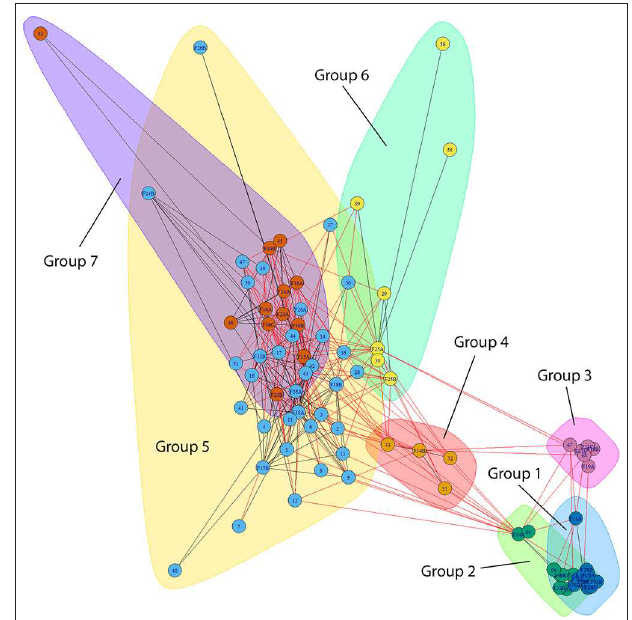
FIGURE 5 | Bipartite graph of network analysis from Tosenfjord tracking data including marine receivers (two-digit numbers) that were operative from 2015 to 2017 tagged fish (two-digit number with F as prefix and ending with A for first year of tracking, ending with B for second year of tracking and C for third year of tracking). Lines indicate connections (edges) between receivers and the detected fish. Color indicate the different subgroups (communities) of receivers and associated tracked fish assigned by a